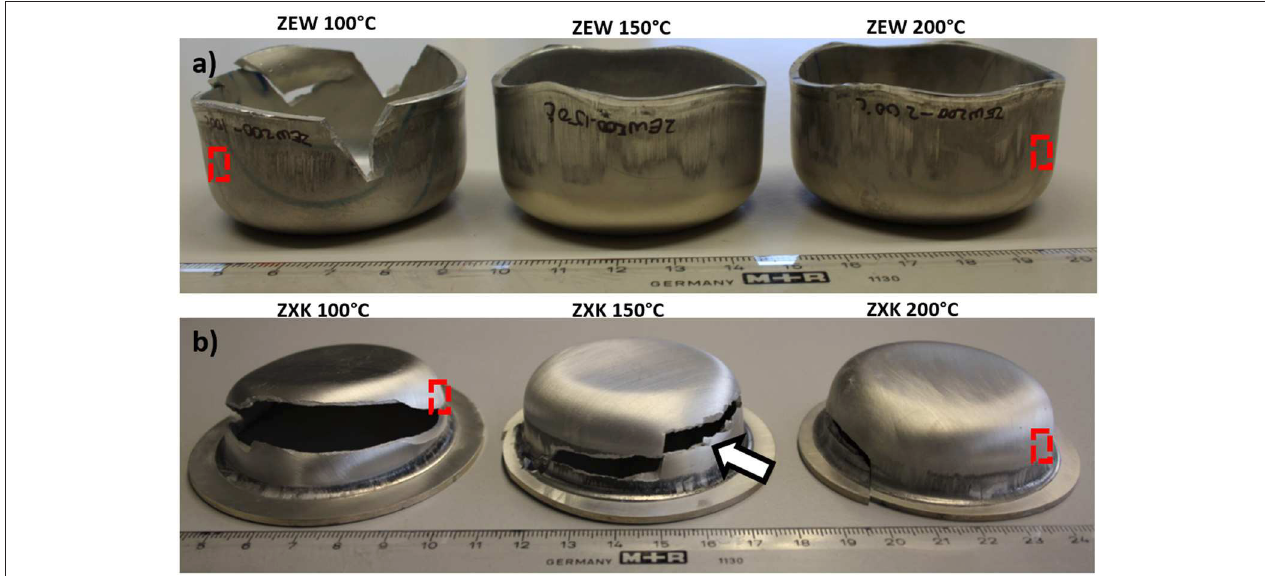
FIGURE 5 | Deep drawn cups formed at different temperatures with a DR = 1.7. (a) Hot rolled and annealed ZEW200 alloy and (b) hot rolled and annealed ZXK alloy.